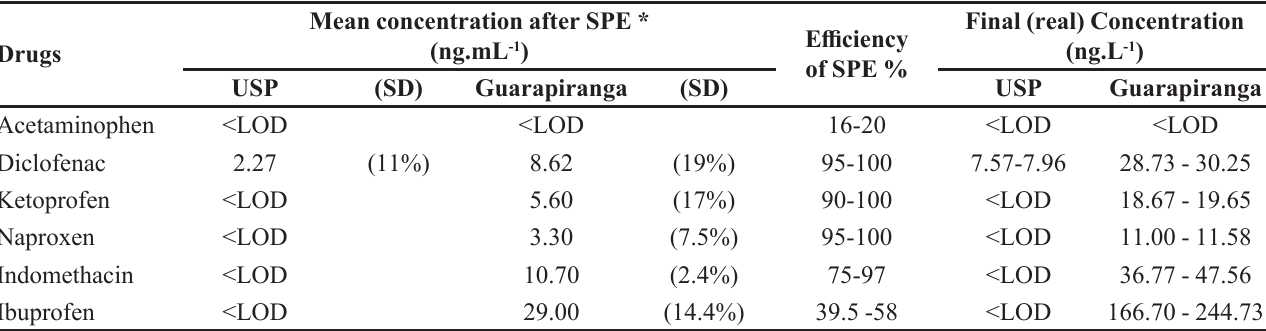
TABLE II - The concentrations of analytes obtained after SPE (300x concentrated) and analytes concentration in environmental samples (n=3), considering the SPE concentration and recovery factor